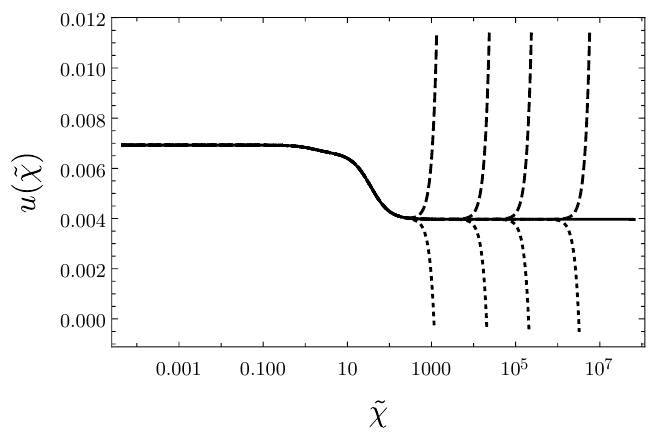
Figure 3 . Flow trajectories of u as functions of ˜ χ with different conditions, for N S = 1 , N F = N V = 0